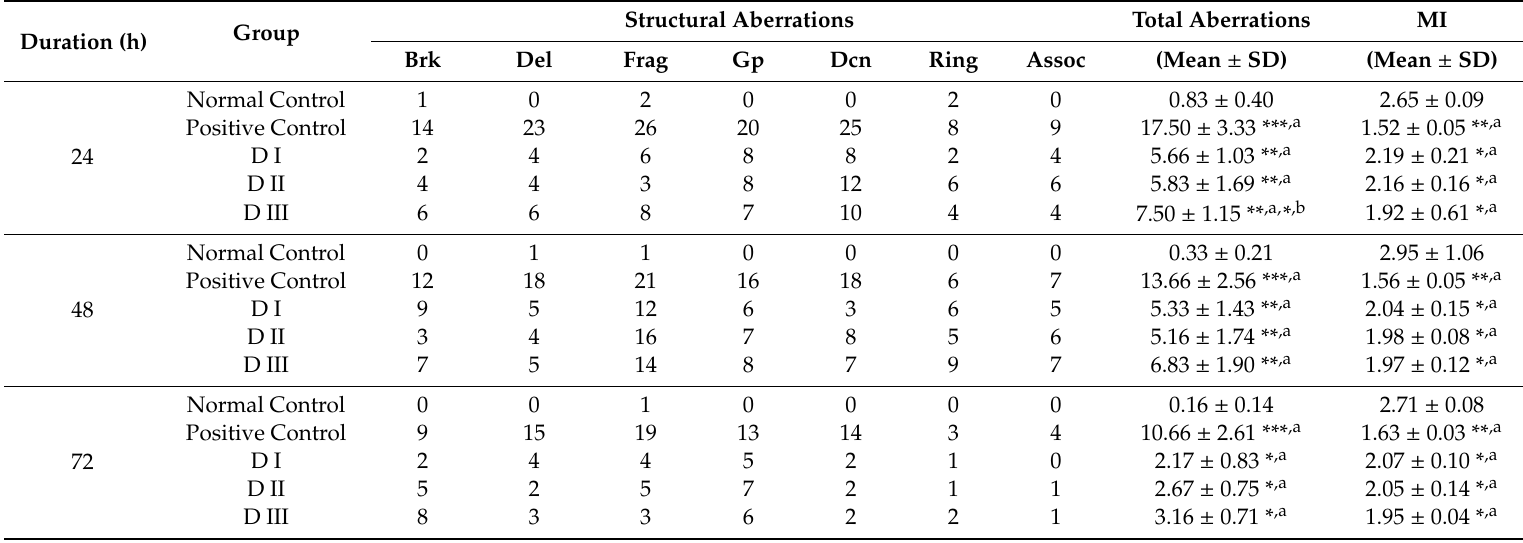
Table 2. Number and mean percentages of chromosomal aberrations and mitotic indices mean percentages in R. norvegicus bone marrow cells after multiple hours of Dimethoate